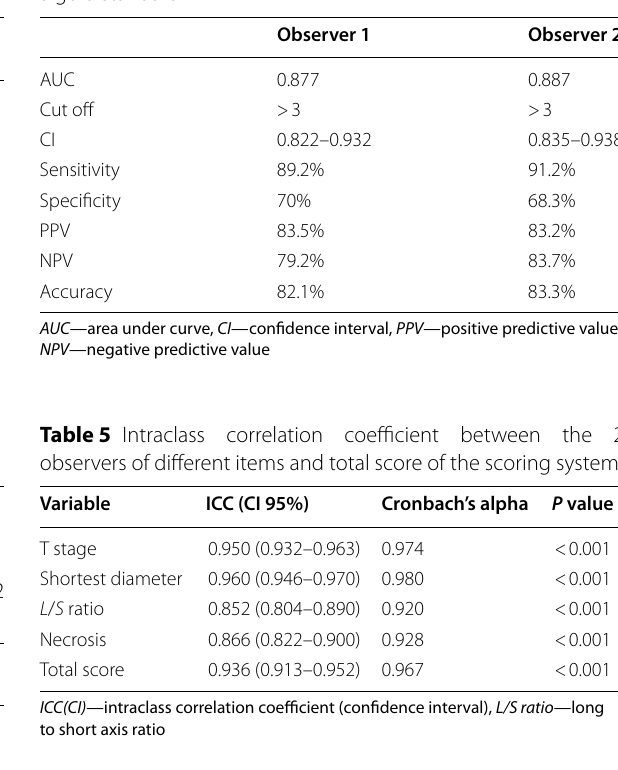
Table 2 Frequency distribution of the different items of the